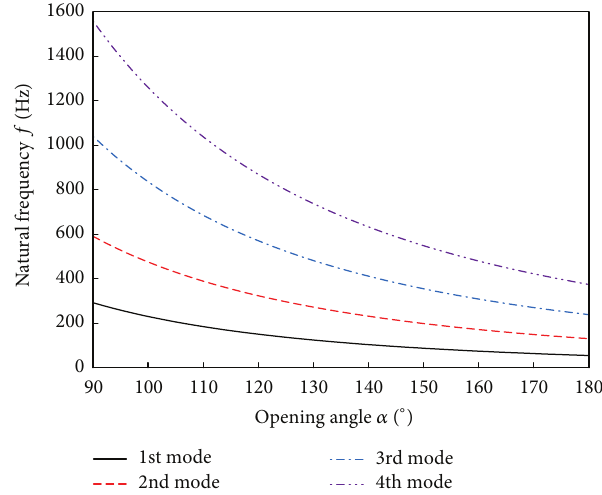
Figure 6: The lowest four natural frequencies of the FGM curved pipes conveying fluid as functions of opening angle for 𝑈 = 120 m/s and 𝑘 = 1